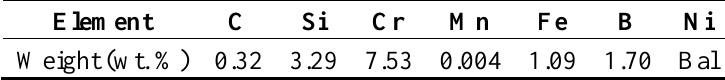
Figure 1. The SEM images of spherical tungsten carbides ( a ) and Ni40 alloy powder ( b ). Table 1. Chemical composition of the Ni40 powder.